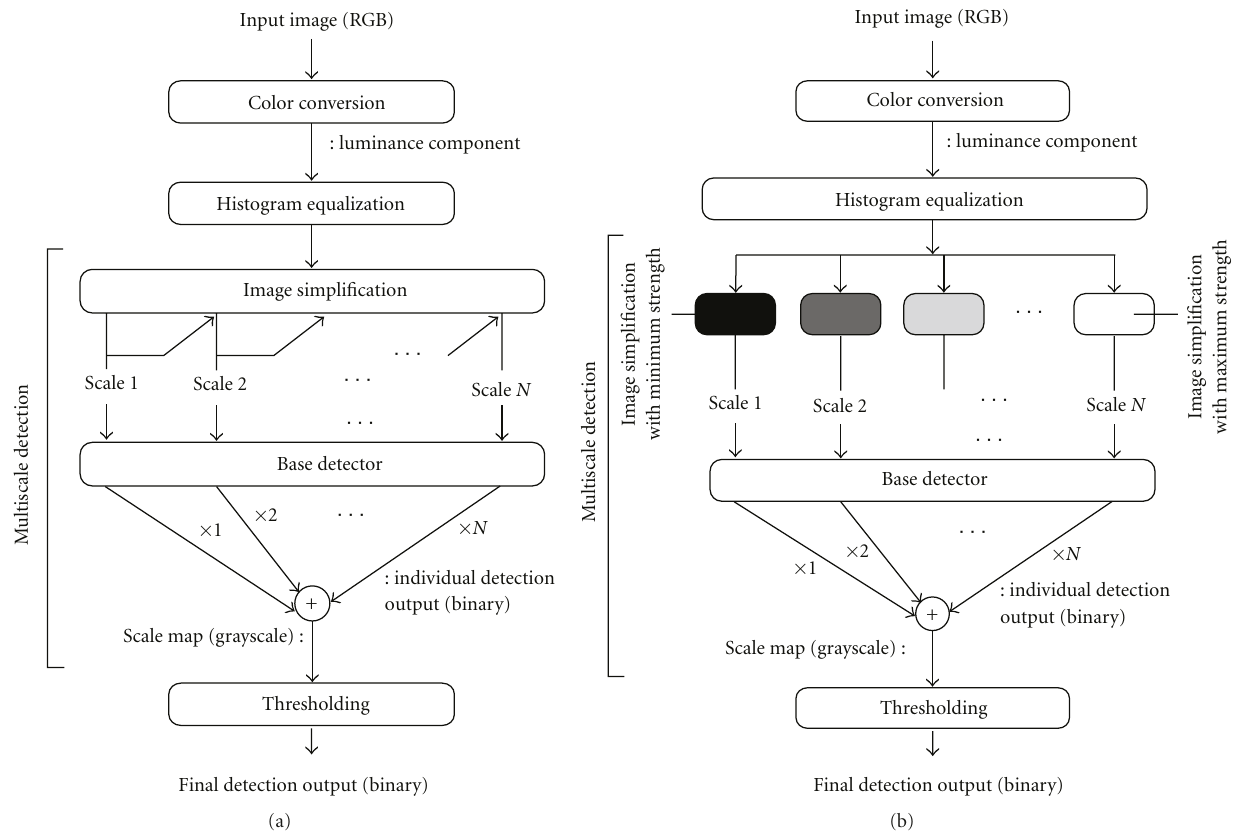
Figure 6: Procedural flows of the proposed multiscale visual detection scheme using sequential (a) and parallel (b) implementation.